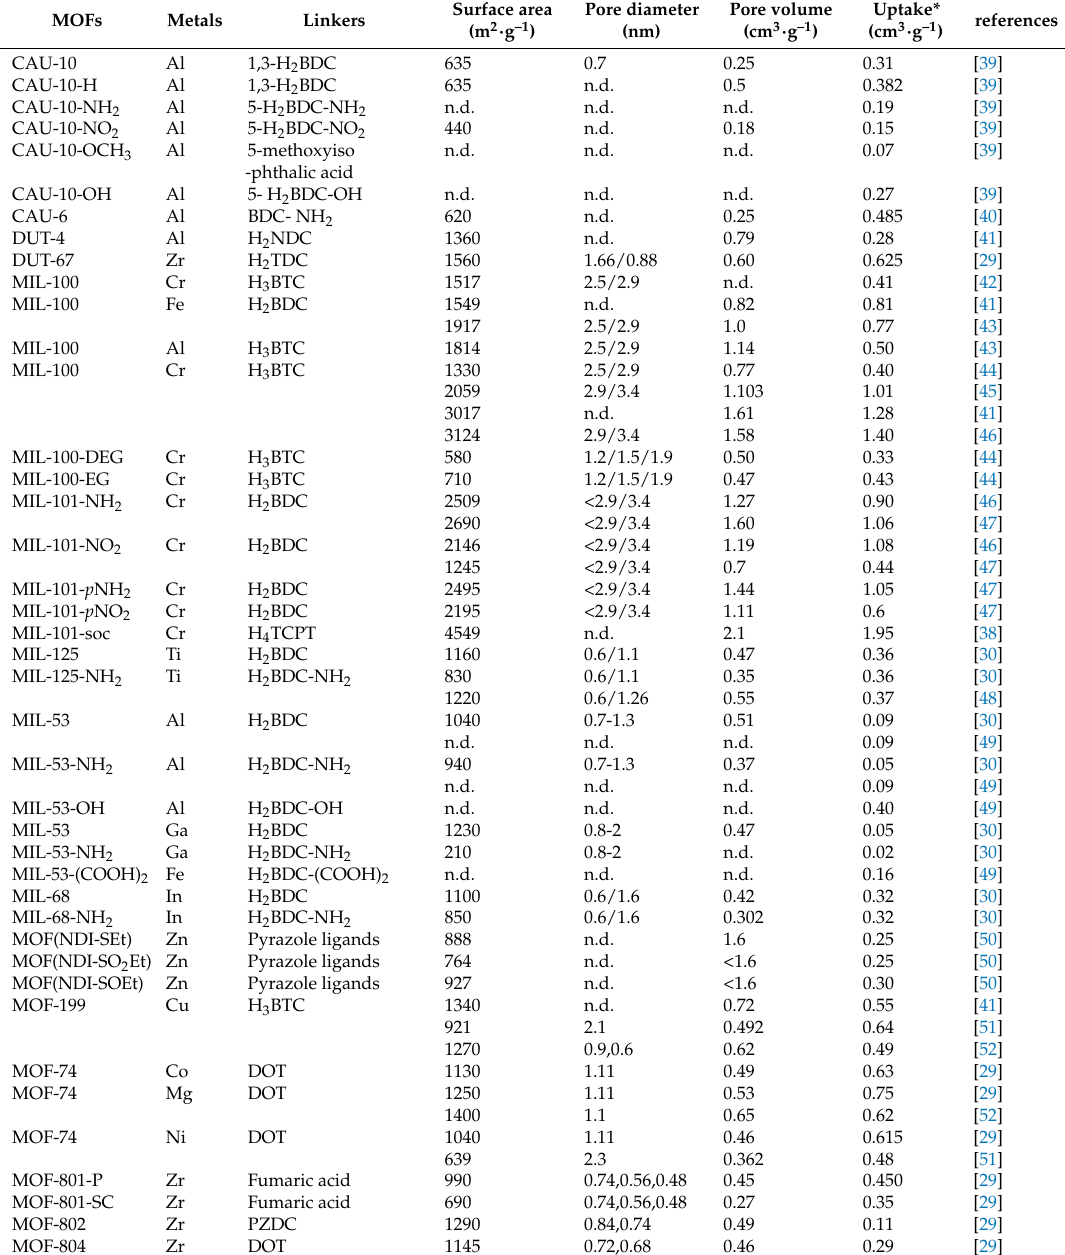
Table 1. Summary of potential MOFs and their properties in water adsorption. Reproduced with permission from [32], Tomsk Polytechnic University,